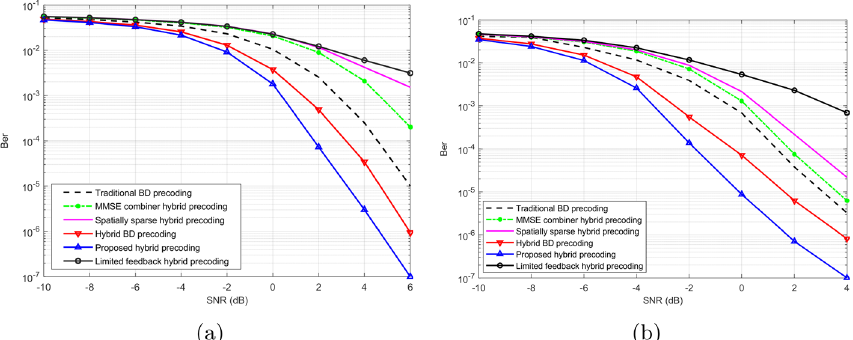
Fig. 7 BER performance comparison for the massive MIMO system in ( a ) mmWave channel; ( b ) Rayleigh